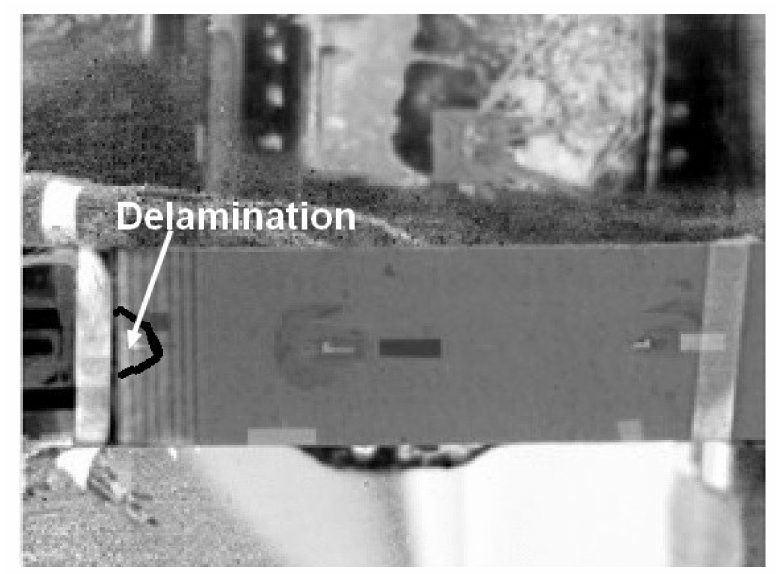
Figure A8. Schematic diagram showing the location and extent of the disbond